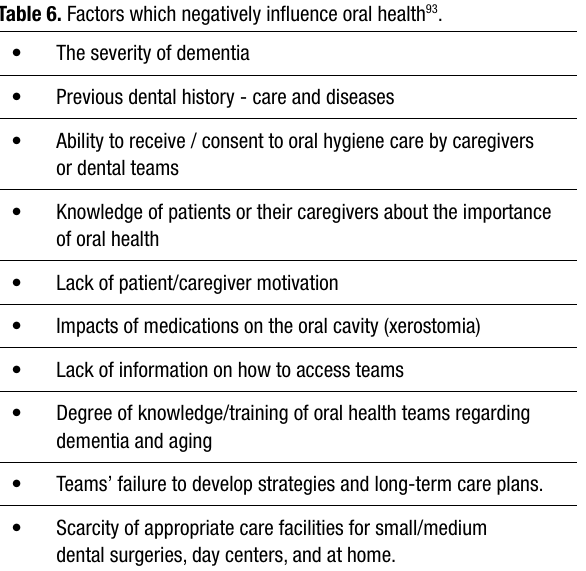
Table 6. Factors which negatively influence oral health 93